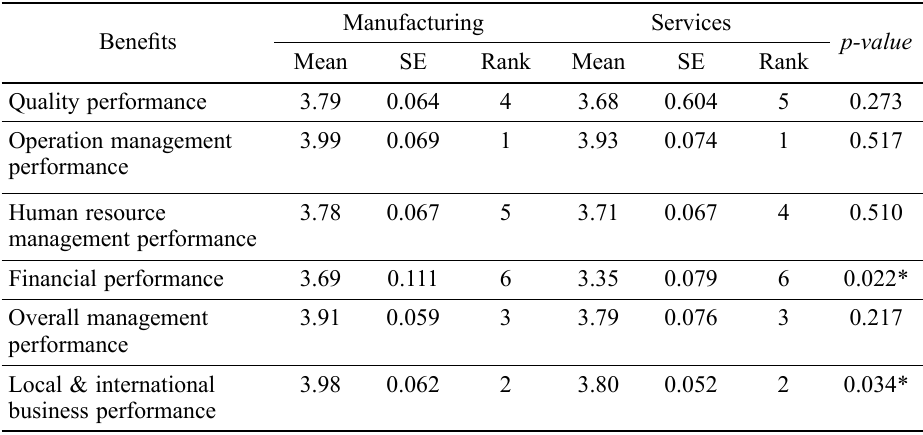
Table 5. Effects of ISO 9001certification classified by type of company